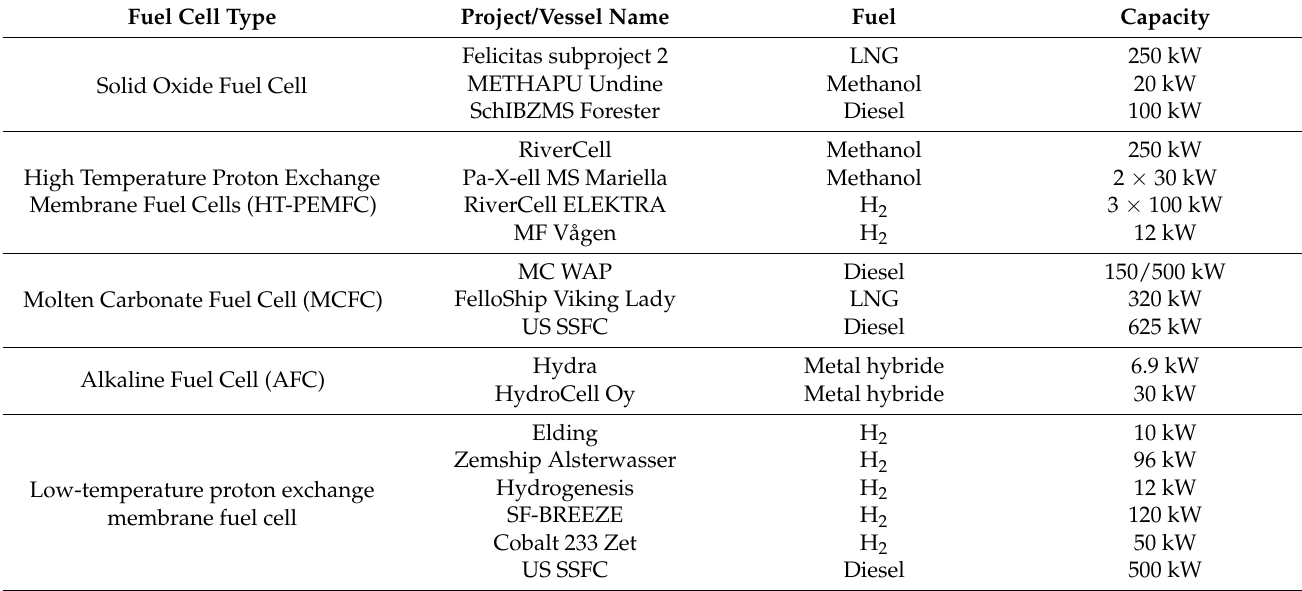
Table 4. List of successful projects according to Xing et al.